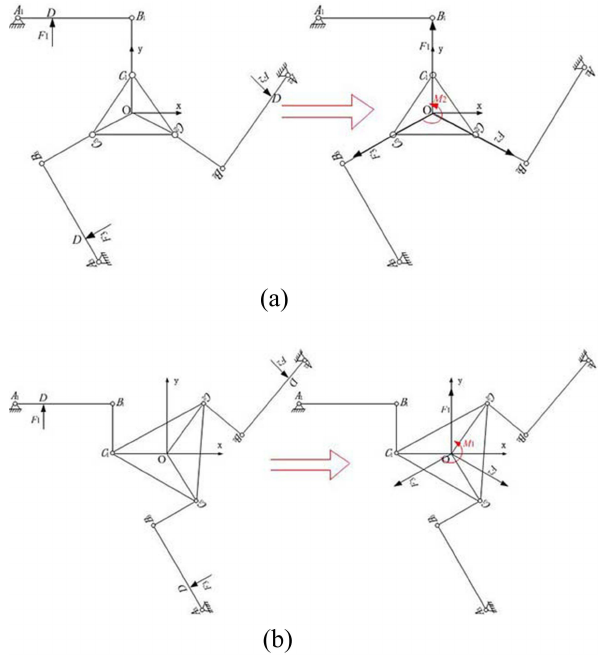
Figure 6. Two different 3-RRR structural configurations.